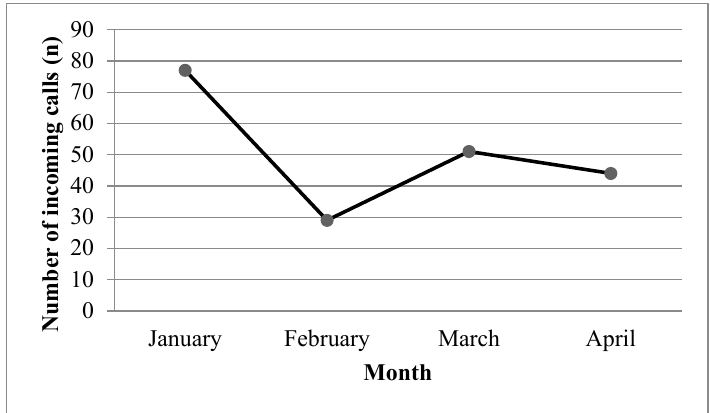
Figure 1. Number of incoming calls to Youth Quitline by month a . a Repeated calls from the same caller were counted as one incoming call.